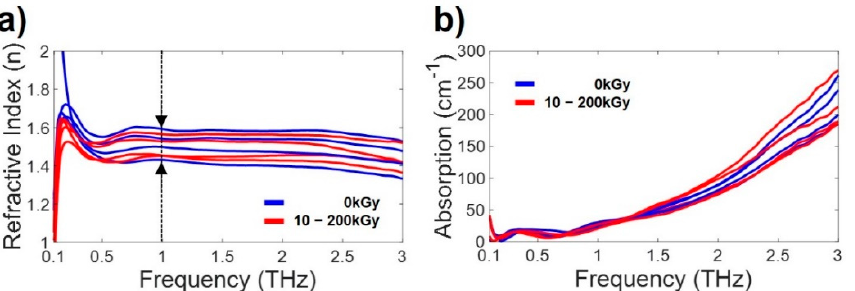
Figure 4. THz measurements of the thin anti-adhesion film. ( a ) Refractive indices. ( b ) Absorption coefficients. Black dot line and arrows indicate the range of refractive indices at 1 THz.